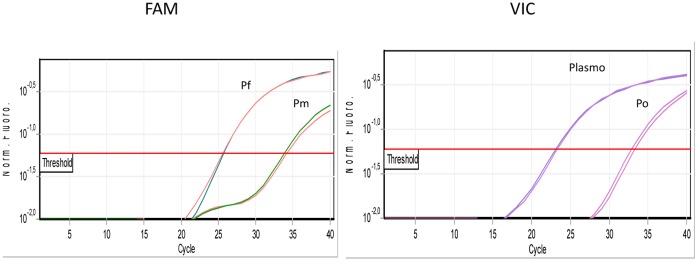
Detection of minor populations by real-time PCR in unbalanced artificial plasmids mixtures.Simultaneous detection of Plasmodium species DNA in a mixture of 18S specific plasmid constructs. A mixture of the three Plasmodium 18S rDNA targets was made with 105 Pf +102 Pm+102 Po.